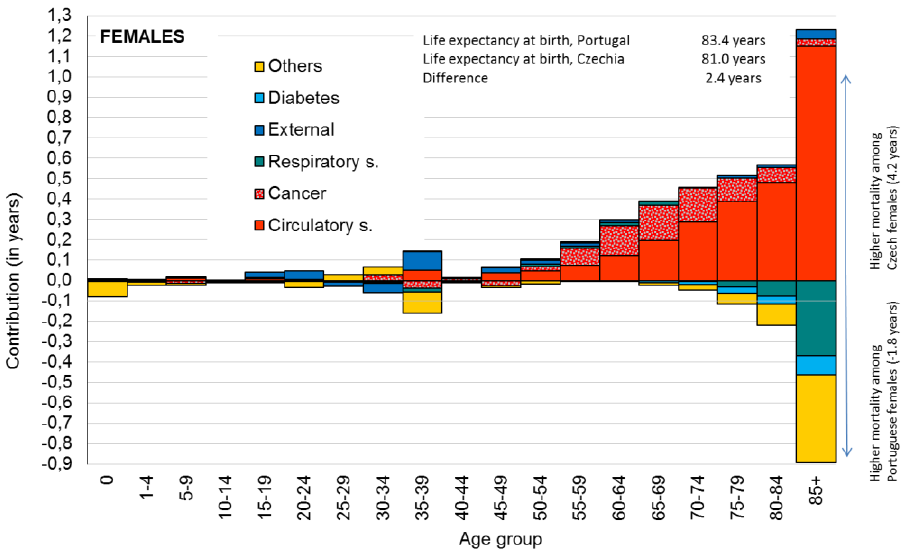
Figure 3. Contribution of age-specific mortality for selected groups of causes to differences in female life expectancy at birth, Portugal vs. Czechia, 2012. Data source: Human Mortality Database. University of California, Berkeley (USA), and Max Planck Institute for Demographic Research (Germany). Available at www.mortality.org or www.humanmortality.de (data downloaded on 13 March 2017). WHO mortality database. (March